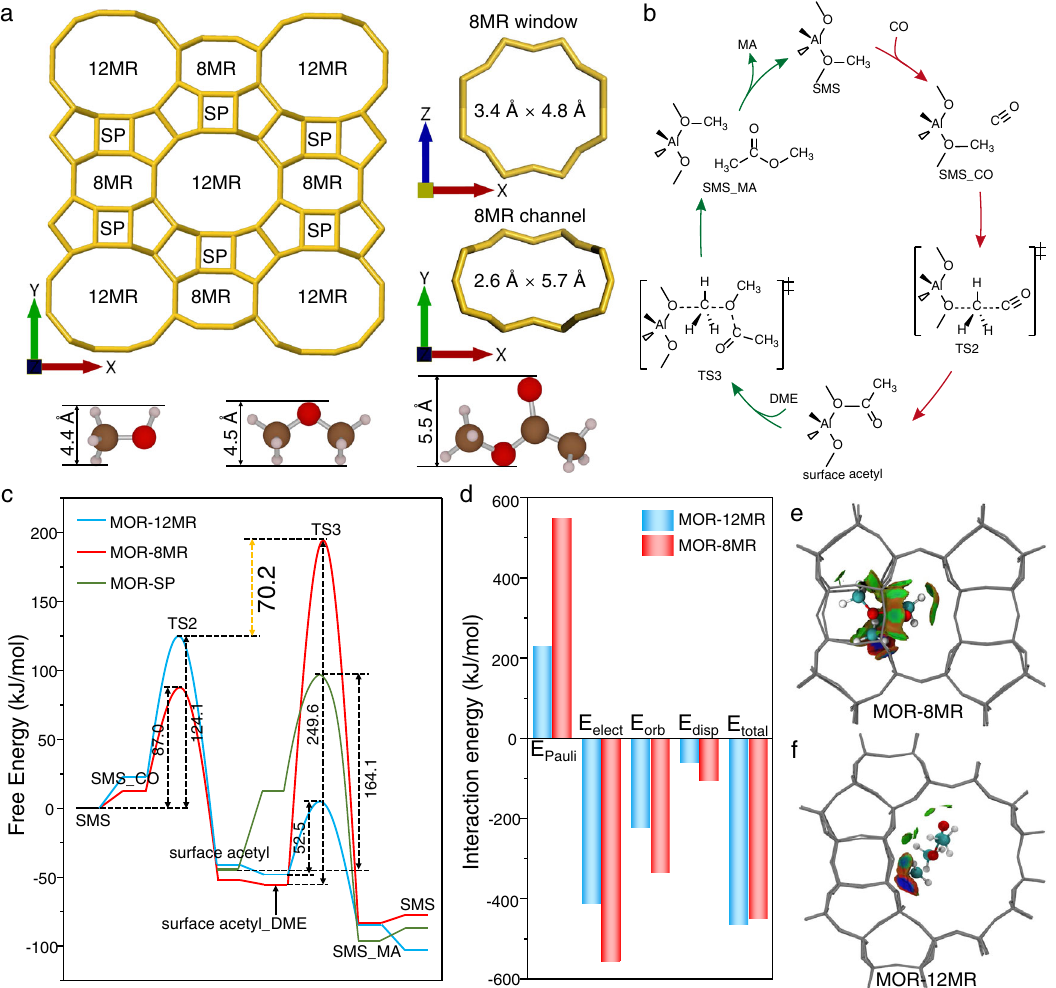
Fig.1 |MechanismofDMEcarbonylationinmordenite.a Poreand channelsizes of mordenite, kinetic sizes of methanol, dimethyl ether, and methyl acetate. The 8MR window refers to the opening between the 12MR channel and the 8MR side pocket (SP) of mordenite. b Catalytic cycle of DME carbonylation, the red arrows indicate the rate-determining step, and the green arrows indicate the fast step. c Free energy pro fi le over MOR-8MR, MOR-12MR, and MOR-SP at 473K obtained